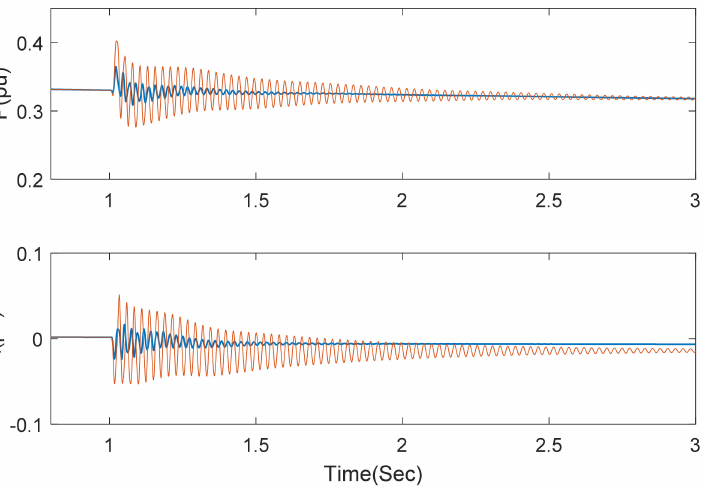
Figure 13. Active responses under the proposed method (blue) and partial feedback linearity (red) at 6 m/s wind speed and 60% compensation with parameter